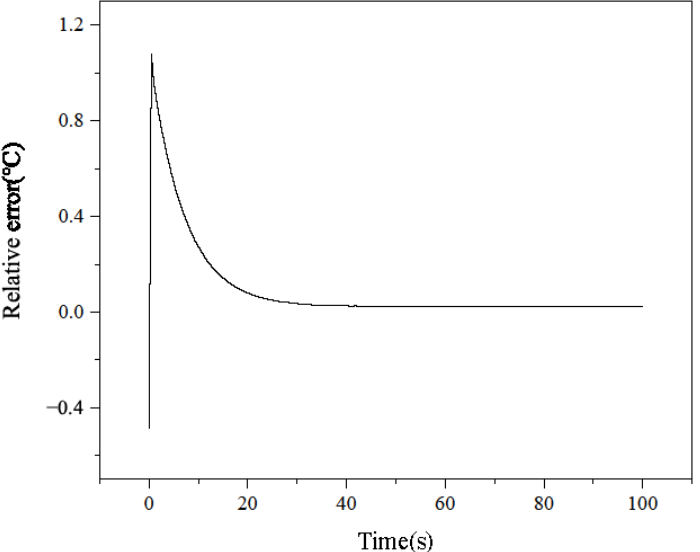
Figure 12. The outlet water temperature result of a 5% step increase in inlet water pressure.